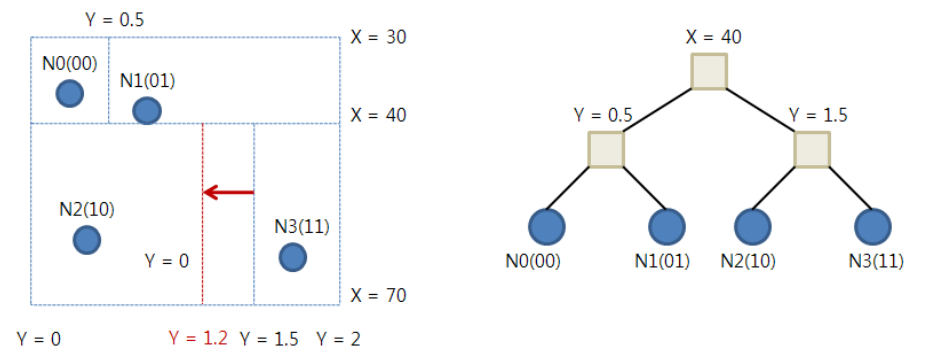
Figure 2. An example of